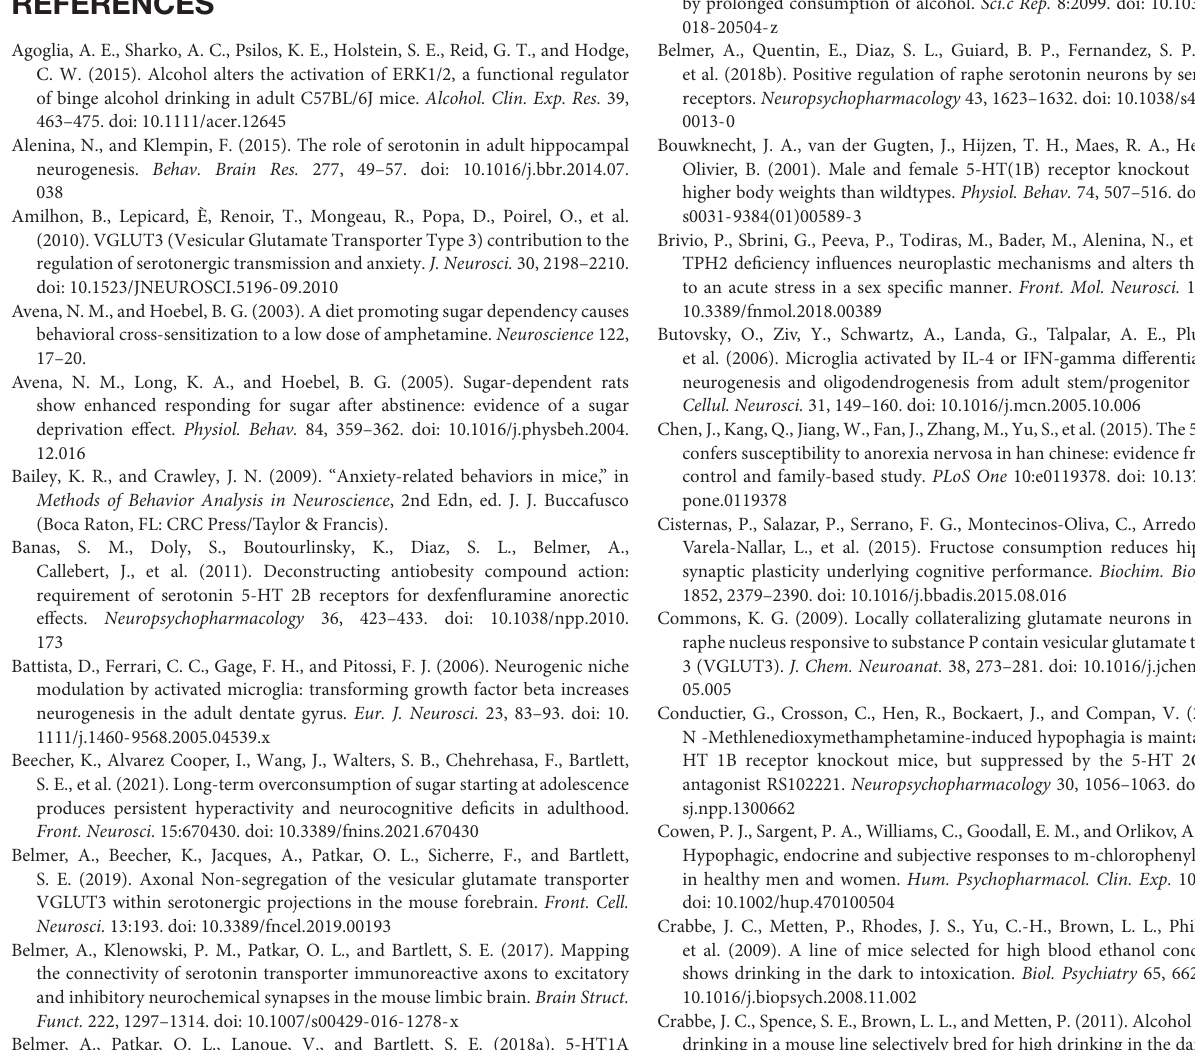
intake around 3–6 g/kg/2 h (mean 4.4 g/kg/2 h indicated by the red line). (B) No weight change was observed across the 16 weeks. Data are presented as mean ± S.E.M; n = 8 mice/group. Supplementary Figure 2 | No change observed in anxious behaviour as seen by the number of marbles buried in marble burying test (A) , number of open arm entries in the elevated-plus-maze (B) , number of entries into the centre in the open-field test (C) , no change in depressive like behaviour as seen by immobility time in the forced swimming test (D) . Data are presented as mean ± S.E.M ( t -test); n = 8 mice/group. Supplementary Figure 3 | (A) No change in the total number of EdU + cells, suggesting no change in overall proliferation. No change in proportion of EdU + co-localised with any stage of neurogenesis: stage 1: glial fibrillary acidic protein (GFAP, B ); stage 2: Nestin (C) ; stage 3: Doublecortin (DCX, D ); stage 4: calretinin (CalR, E ) and stage 5: calbindin (CalB, F ) suggesting no change in neurogenesis. No change in proportion of EdU + co-localised with glial populations: oligodendrocyte (olig2, G ) and microglia (IBA, H ). Data are presented as mean ± S.E.M ( t -test); n = 8